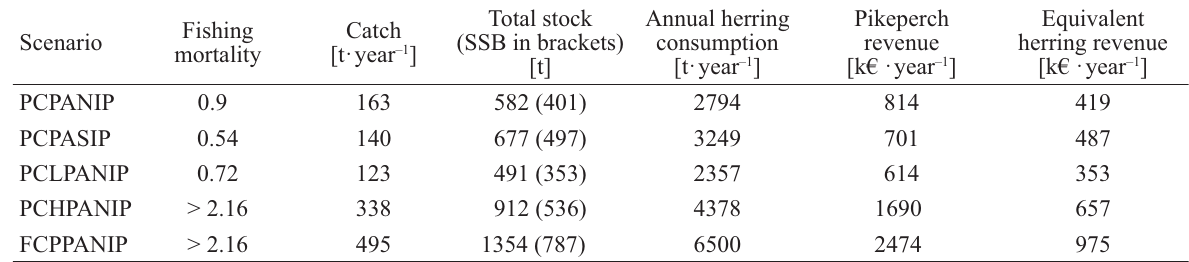
Fishing mortality, annual catch, equilibrium total stock biomass and revenue generated at maximum catch of pikeperch ( Sander lucioperca ) for simulated scenarios, compared to potential revenue generated from harvesting equivalent herring prey